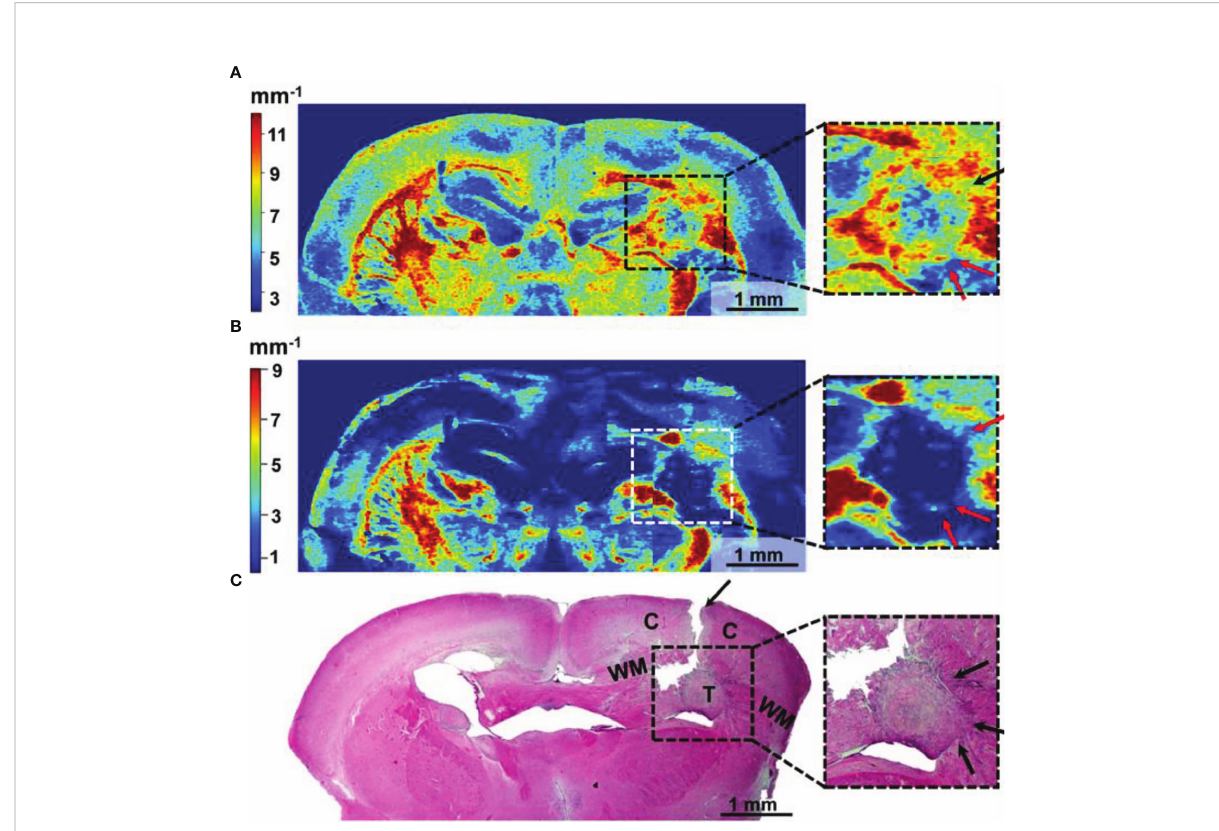
FIGURE 8 Wide- fi eld OCT color-coded maps of the mouse brain with GBM7-Luc2-mKate2 tumor (A, B) and corresponding histology (C) . Color-coded maps based on two optical coef fi cients calculation: attenuation in co-channel (Att co- ) (A) and in cross-channel (Att cross- ) (B) . Perifocal areas of high cancer density are marked with arrows (see enlarged fragments). T, tumor; C, cortex; WM, white